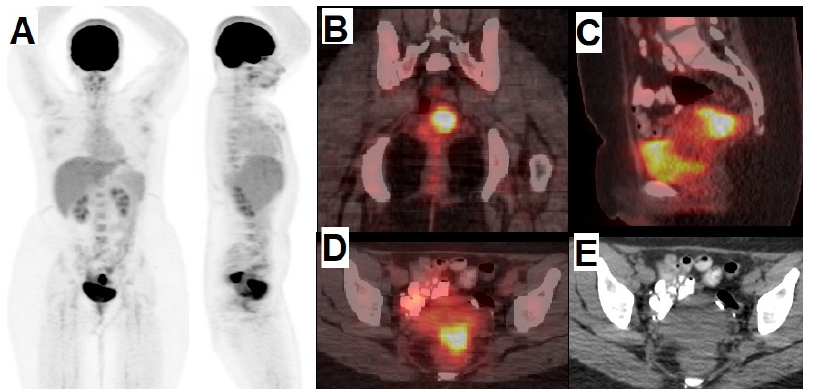
Figure 5. 21-year-old female, known case of vaginal rhabdomyosarcoma, referred for staging. ( A ) anterior and right lateral MIP [ 18 F]FDG PET/CT images. ( B ) coronal, ( C ) sagittal, ( D ) transvers pelvis fused [ 18 F]FDG PET/CT images and ( E ) corresponding transvers pelvis CT image showed hypermetabolic primary tumor without evidence of regional lymphadenopathy or distance metastasis.